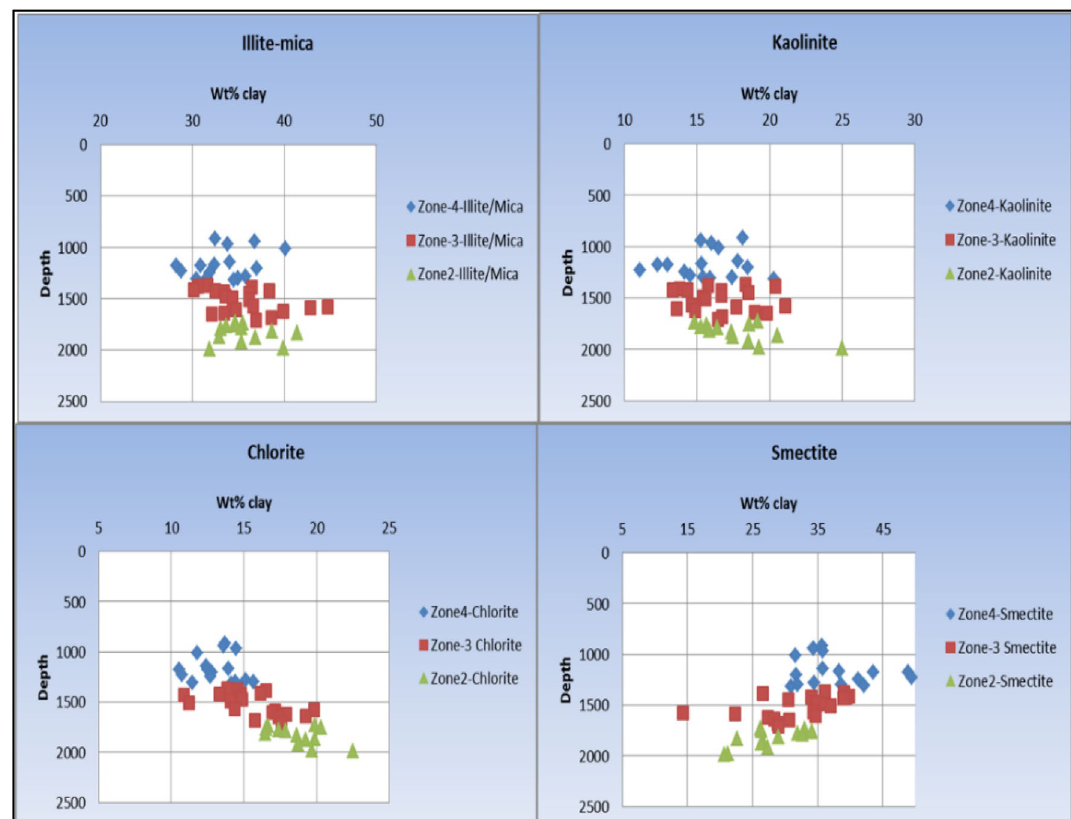
Fig. 9 Well 1 XRD results of multiple samples from different zones defined in Fig.